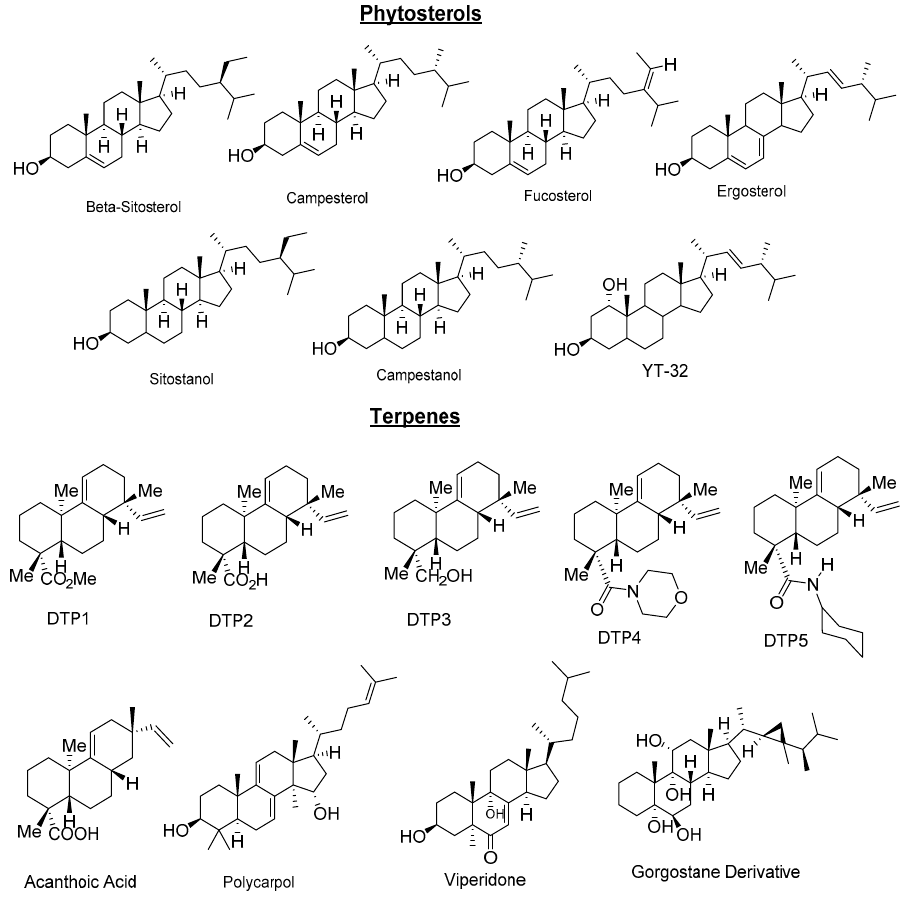
Figure 4. Selected phytosterols and terpenes as naturally occurring LXR ligands.